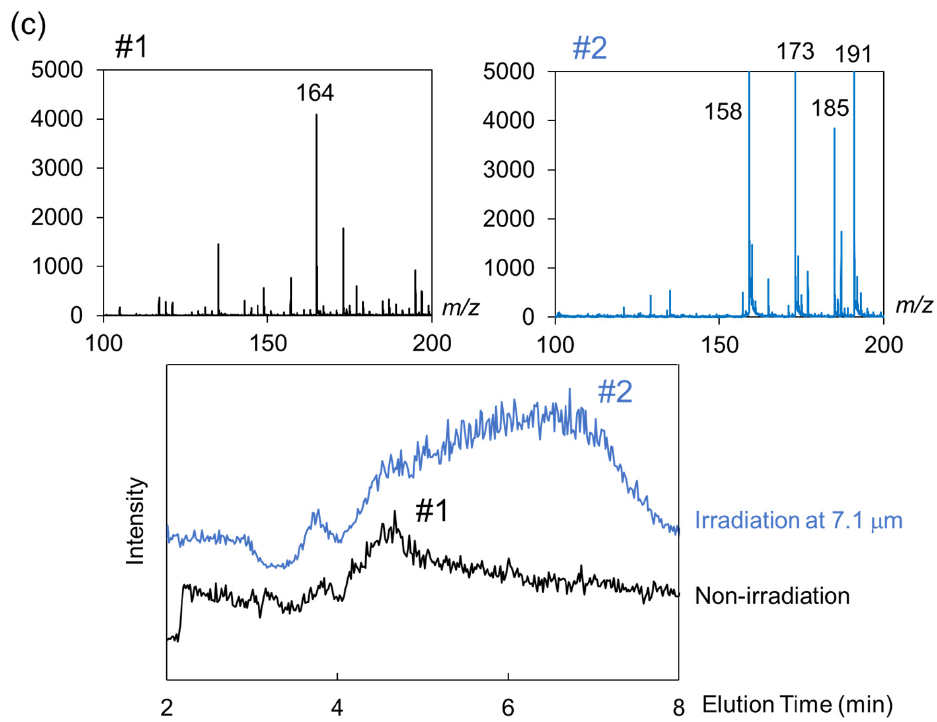
Figure 3. Irradiation effect of IR-FEL at mid-infrared wavelengths. ( a ) Infrared microspectroscopy observation of lignin before (black) and after irradiation at 6.3 µ m (green) and 7.1 µ m (blue). The right photographs show optical microscope images for surfaces of the dry lignin before and after irradiation. White bar: 200 µ m. ( b ) ESI-MS spectra in the high-molecular weight region. Upper: lignin before irradiation; below: lignin after irradiation at 7.1 µ m. ( c ) ESI-MS chromatography analysis in the low-molecular weight region. Black: lignin before irradiation; blue: lignin after irradiation at 7.1 µ m. Upper: mass spectra; below: mass chromatograms of lignin before (#1) and after (#2) irradiation. The 2D 13 C- 1 H HSQC and 2D 13 C- 1 H HMBC spectra of the sample after irradiation at 7.1 µ m are superimposed in Figure 4c. The signals of the 2D 13 C- 1 H HSQC spectrum